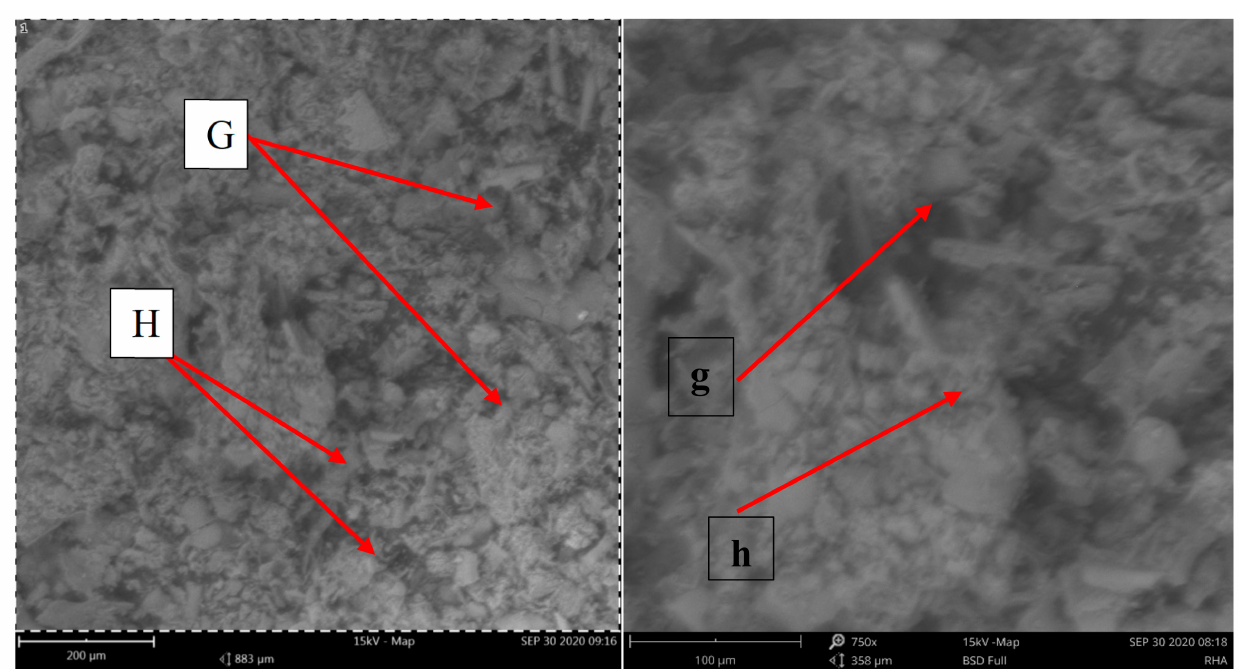
Figure 5. The SEM images of